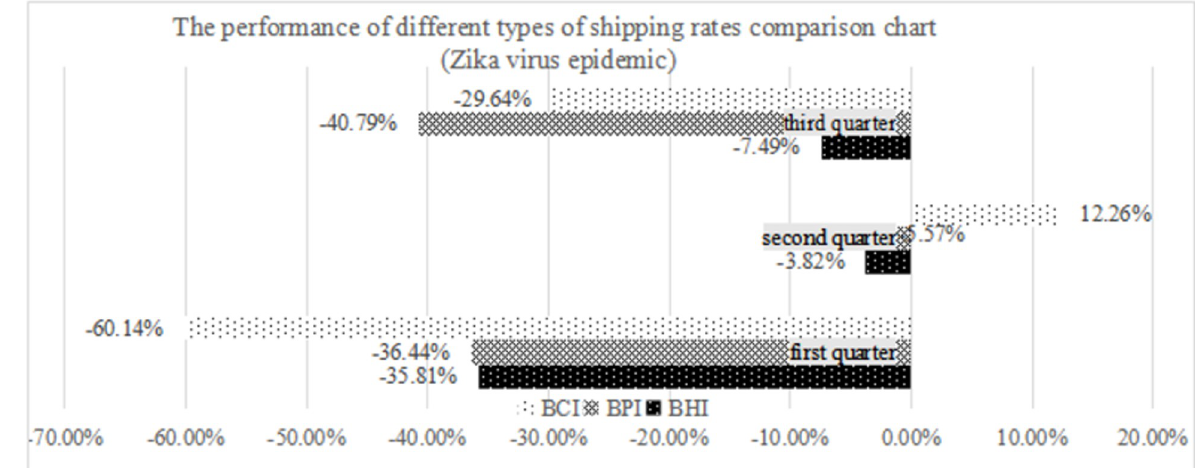
Fig 7. The performance of different types of shipping rate comparison charts (Zika virus